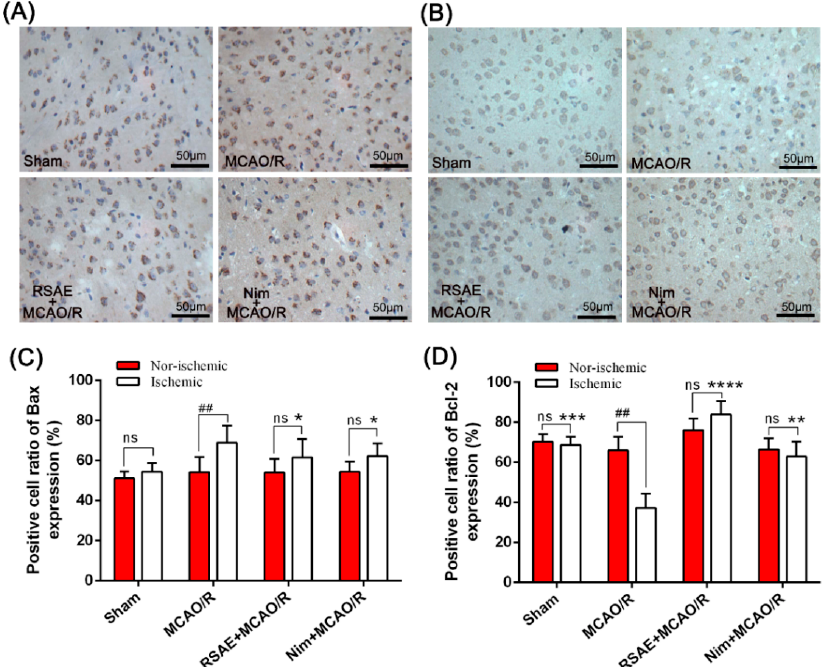
Figure 7. Effect of RSAE on the levels of Bax- and Bcl-2-positive cells in mice with focal cerebral ischemia at 24 h after ischemia/reperfusion. ( A ) Representative immunohistochemical staining images of pro-apoptotic Bax in the ischemic and nonischemic neuron sections at 24 h after ischemia/reperfusion. ( B ) Representative immunohistochemical staining images of anti-apoptotic Bax in the ischemic and nonischemic neuron sections at 24 h after ischemia/reperfusion. ( C ) Quantitative analysis of Bax-positive cells in mice with focal cerebral ischemia at 24 h after ischemia/reperfusion. ( D ) Quantitative analysis of Bcl-2-positive cells in mice with focal cerebral ischemia at 24 h after ischemia/reperfusion. Mean values ± standard error of the mean (n = 10); * p < 0.05, ** p < 0.01, ***** p < 0.0001 versus MCAO/R group; # p < 0.05, ## p < 0.01, #### p < 0.0001 versus sham-operated group; ns means not significant. Scale bar, 50 µ